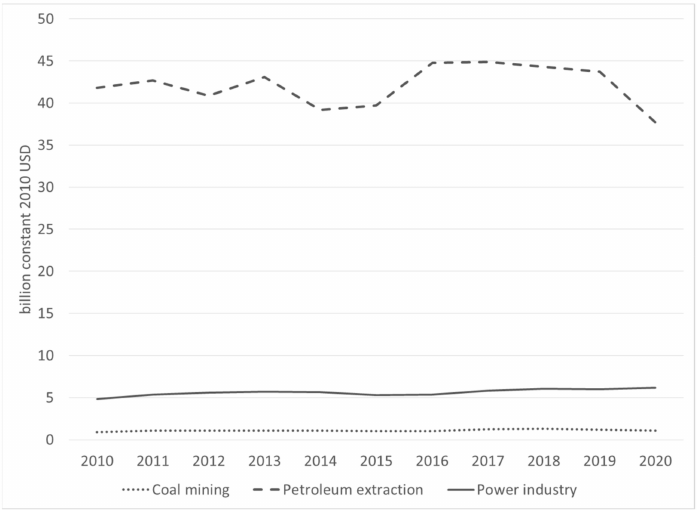
Figure 1. Energy sector output value. Source: Ministry of Economy of Kazakhstan “Industry of Kazakhstan”, various years.